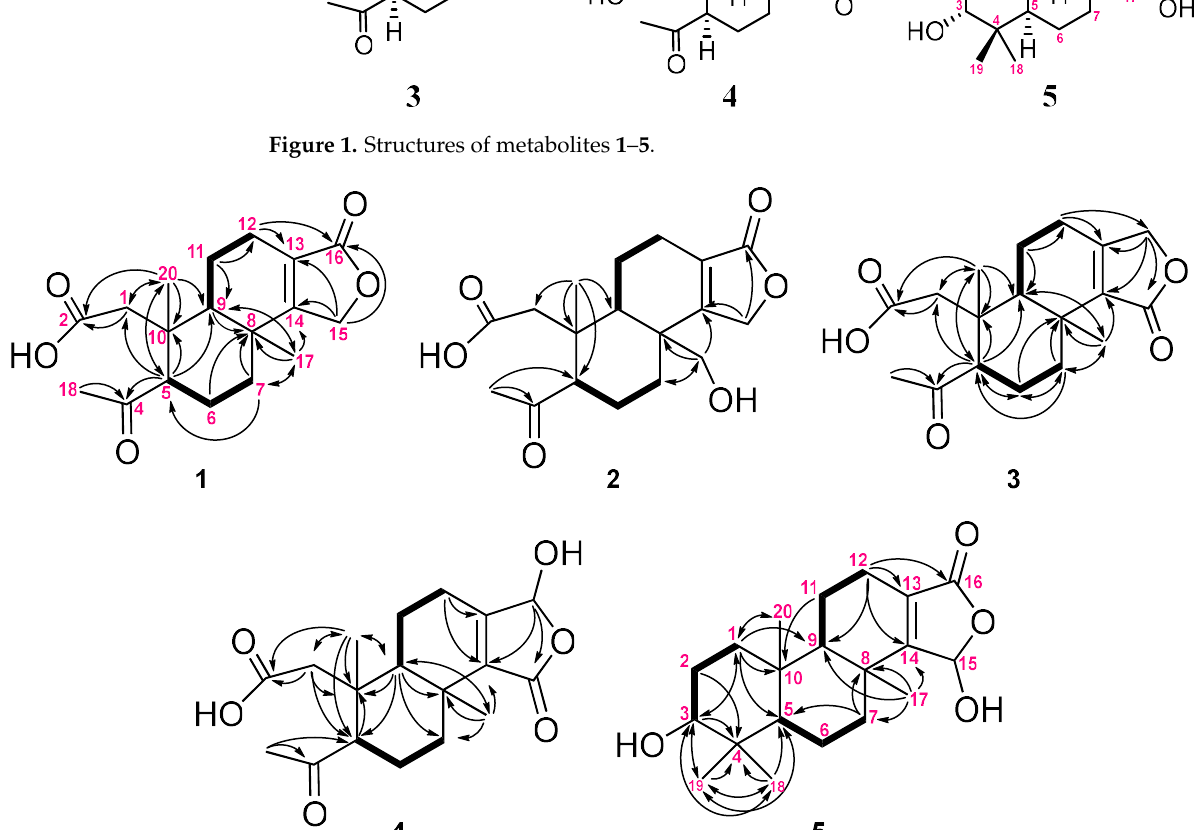
Figure 2. The selected COSY ( ▬ ) and HMBC ( → ) correlations of 1 – 5 .